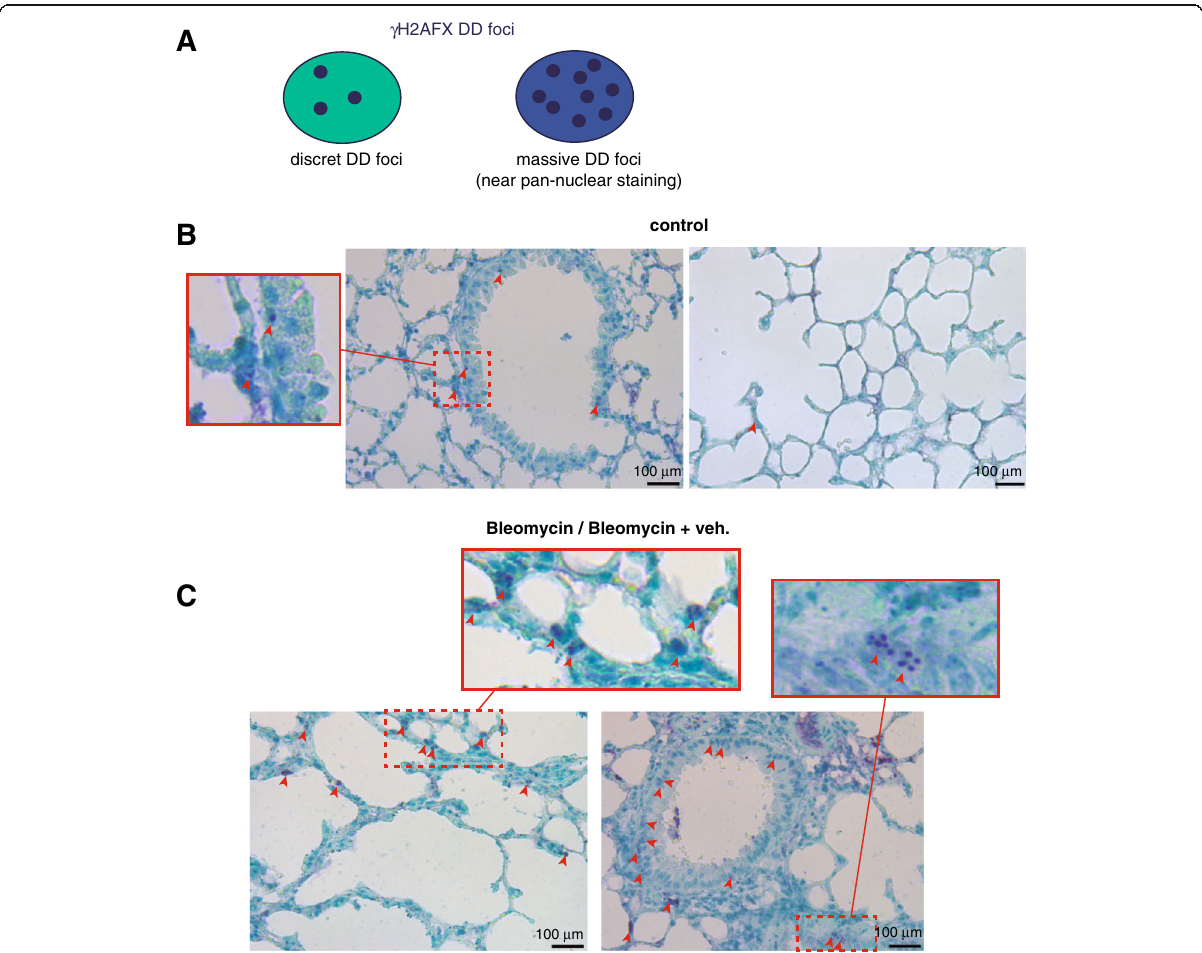
Fig. 8 DNA damage expression in lung tissue: expression of γ H2AFX foci. a Illustration showing the staining pattern of γ H2AFX. γ H2AFX is typically expressed as discrete foci or as a near pan-nuclear staining when the occurrence of DD foci is massive. b Expression of γ H2AFX foci in representative sections of lung tissue from control mice (treated with saline). A magnification of an image of a respiratory bronchiole is depicted in the square on the left. Arrowheads signal some of the nuclei harboring DD foci containing γ H2AFX distributed throughout the respiratory bronchiole or in alveolar fields (photograph on the right). c Expression of γ H2AFX foci in representative sections of lung tissue from mice treated with bleomycin or bleomycin + vehicle. Two magnifications of the images are depicted in the rectangles on the top. Arrowheads signal some of the nuclei harboring some DD foci containing γ H2AFX indicative of severe DNA damage. The magnitude and distribution of the damage observed was very similar in both groups. Scale bars: 100 μ